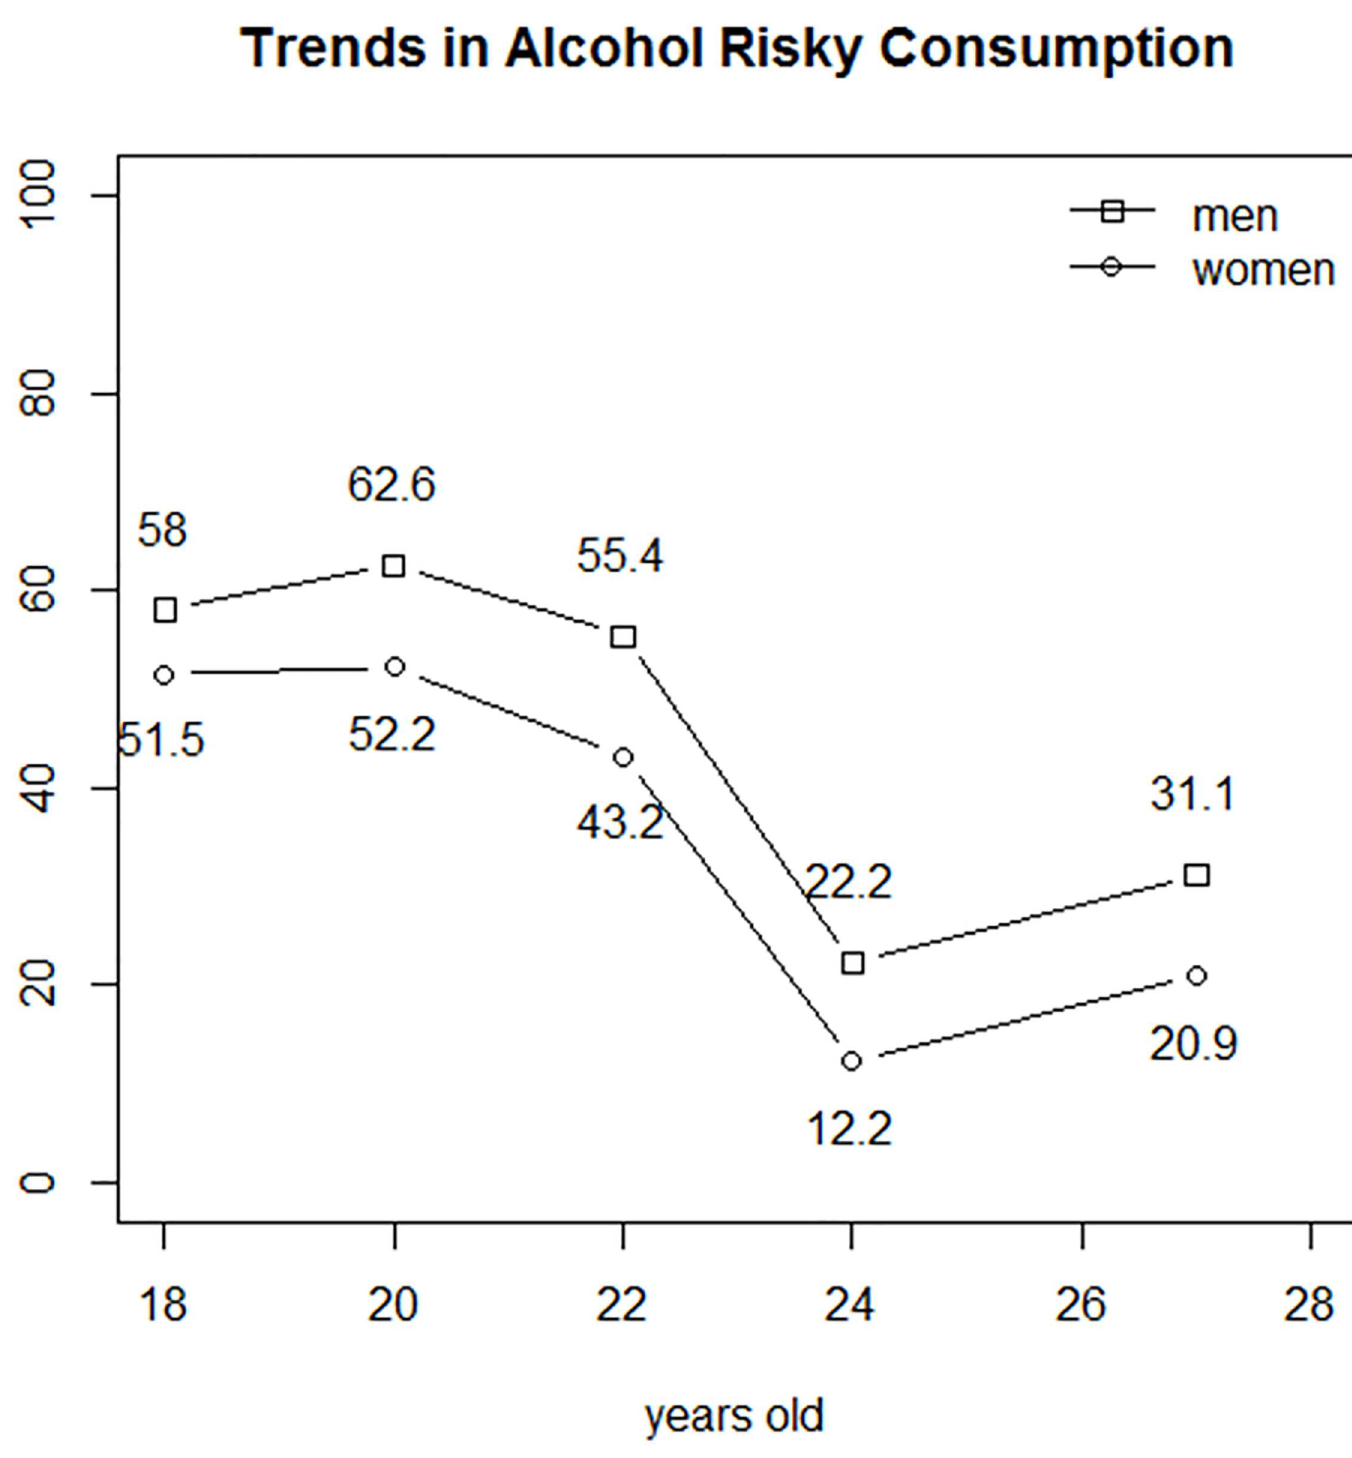
Fig 1. Prevalences of risky consumption among female and male Spanish university students from 18–19 years old to 27–28 years old.